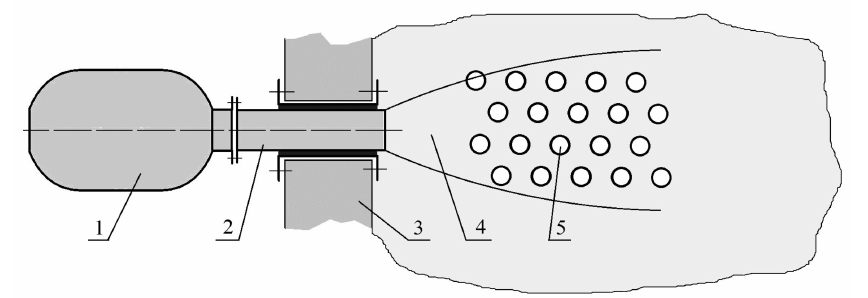
Figure 1. A typical installation diagram of a pneumopulse generator for cleaning a tubular heat exchanger. 1—pneumopulse generator; 2—exhaust pipe; 3—boiler wall; 4—pulsed gas jet; 5—heat exchange